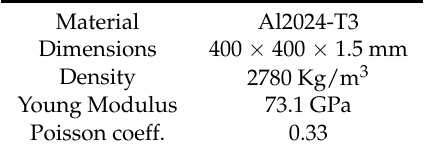
Table 1. Dimensions and mechanical characteristics of the metallic